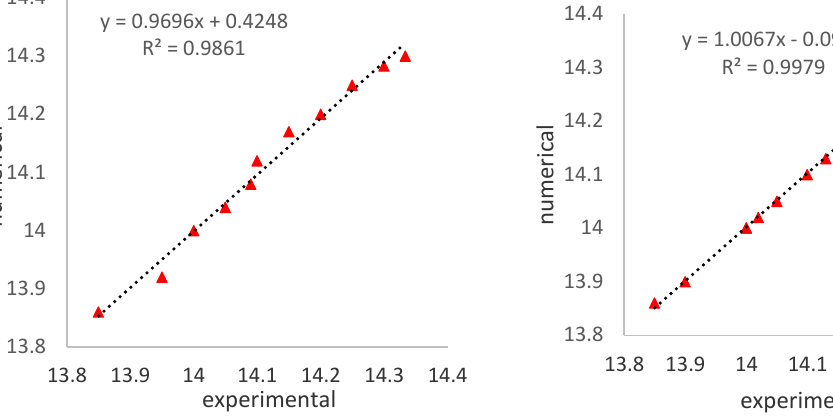
Fig 7. Comparison of the flow depth in lateral axis Fig 8. Comparison of the flow depth in central